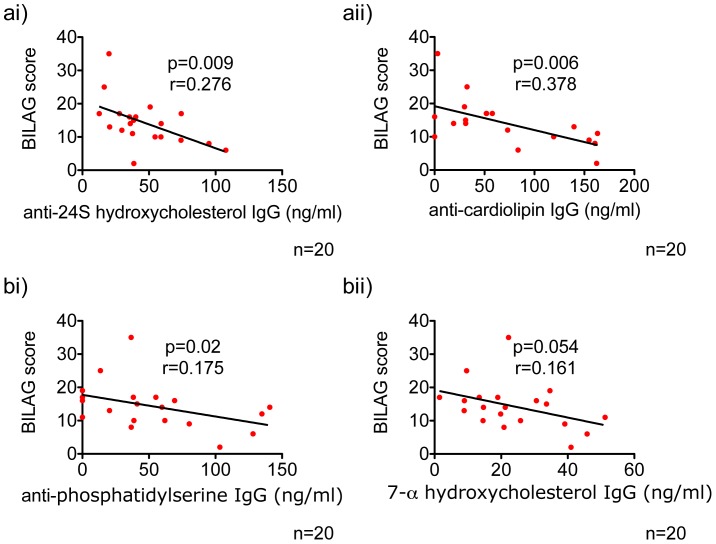
Biomarker candidates that correlate with BILAG scores.
Figure 5ai, 5bi, 5ci. Anti-24S hydroxycholesterol IgG, anti-cardiolipin IgG and anti-phosphatidylserine IgG levels negatively correlate with BILAG scores. Figure 5bii. Anti-7-α-hydroxycholesterol IgG levels also show trend of negative correlation with BILAG scores. p<0.05 value was considered as significant in Spearman correlation and Linear regression tests.